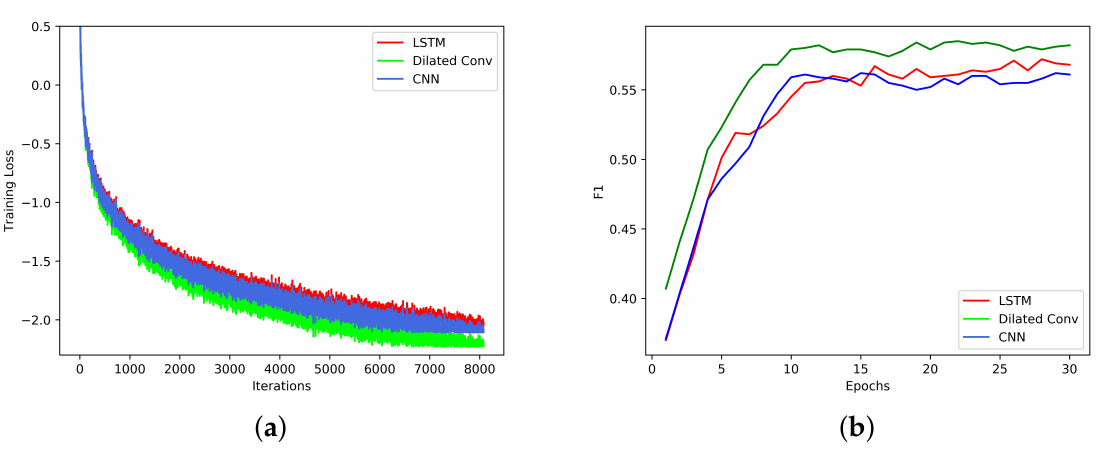
( c ) Figure 9. Comparison of results of our model and baselines on sentences that contains different number of triplets ( ≤ 7 ) . ( a ) The value of precision of different methods; ( b ) The value of recall of different methods; ( c ) The value of F1 of different methods.